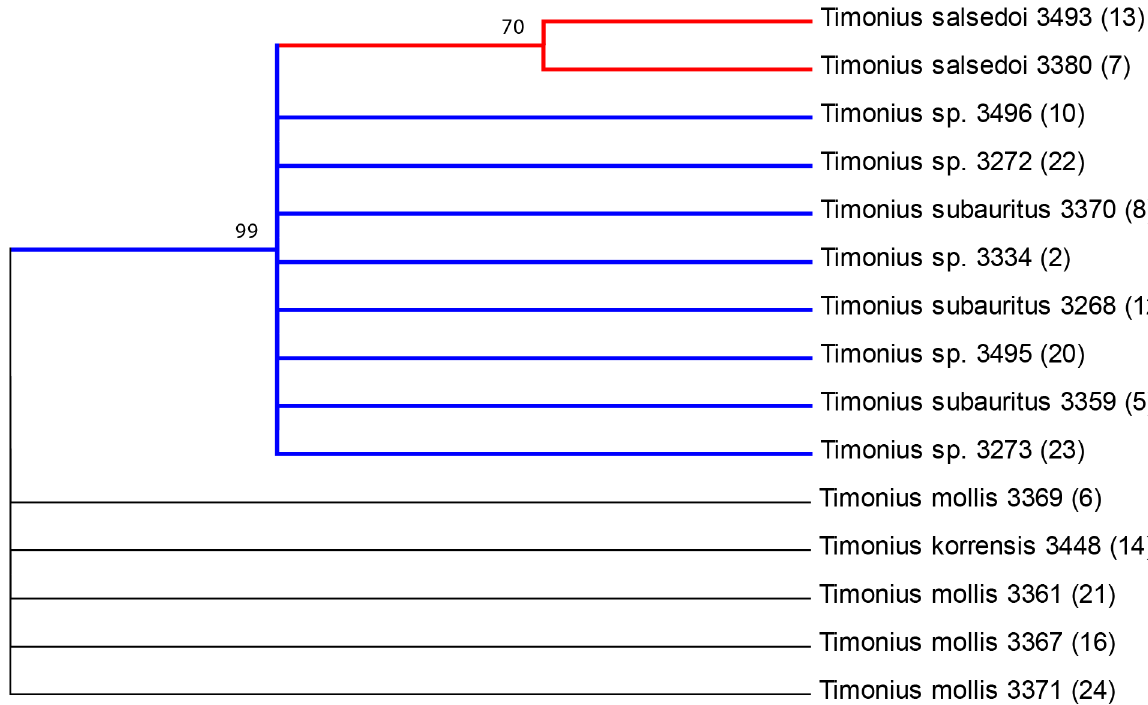
Fig 5. Maximum parsimony tree from seven-locus alignment ( rbcL , matK , ITS , trnH-psbA , trnL-trnF , petD , atpB-rbcL ) with bootstrap support values at branch nodes and species followed by collection number (DNA sample number) at the branch tips. The tree shown is the bootstrap consensus tree inferred from 1,000 replicates, Branches with < 50% support are collapsed. The lineage of T . subauritus is highlighted in blue and T . salsedoi is highlighted in